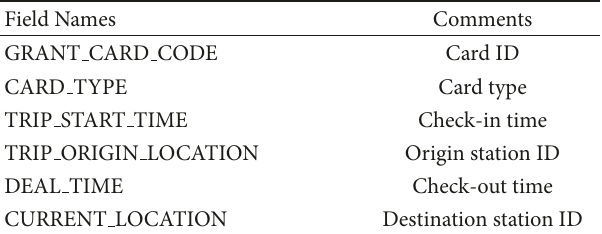
Table 3: Data structure of smart card transaction